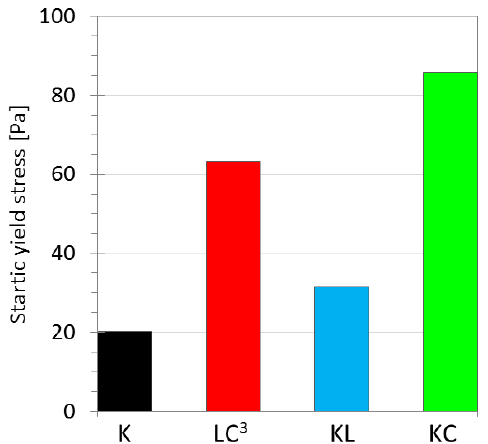
Figure 4. Static yield stress τ S of sheared binders at an early age (0 min).